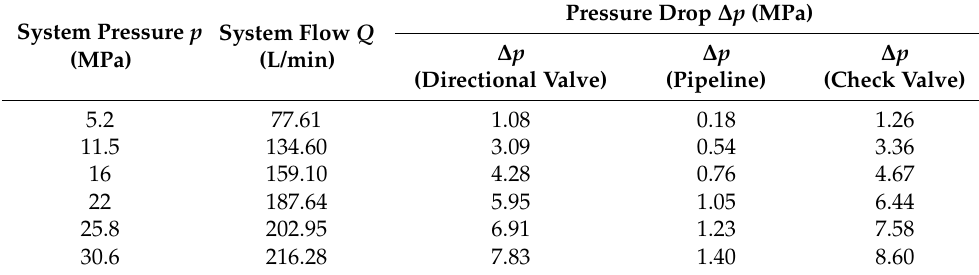
Table 6. Hydraulic cylinder extension data under DN20 pipeline